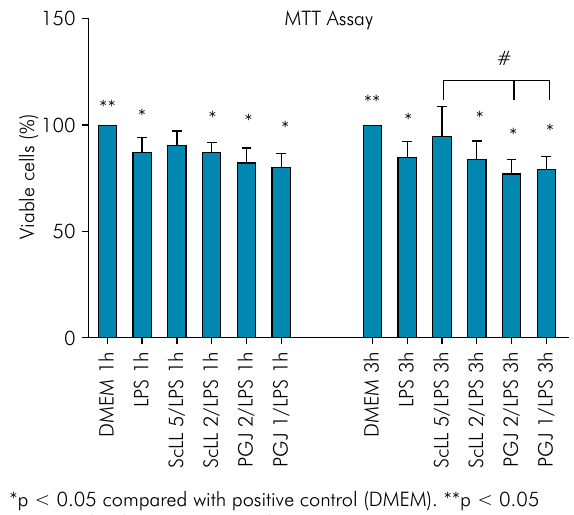
Figure 1. Effect of 15d-PGJ and ScLL on cell viability of 2 HGFs at 1 h and 3 h by MTT assay. Statistical significance was determined using one-way ANOVA and Dunnett’s test. #p<0.05 compared among the experimental